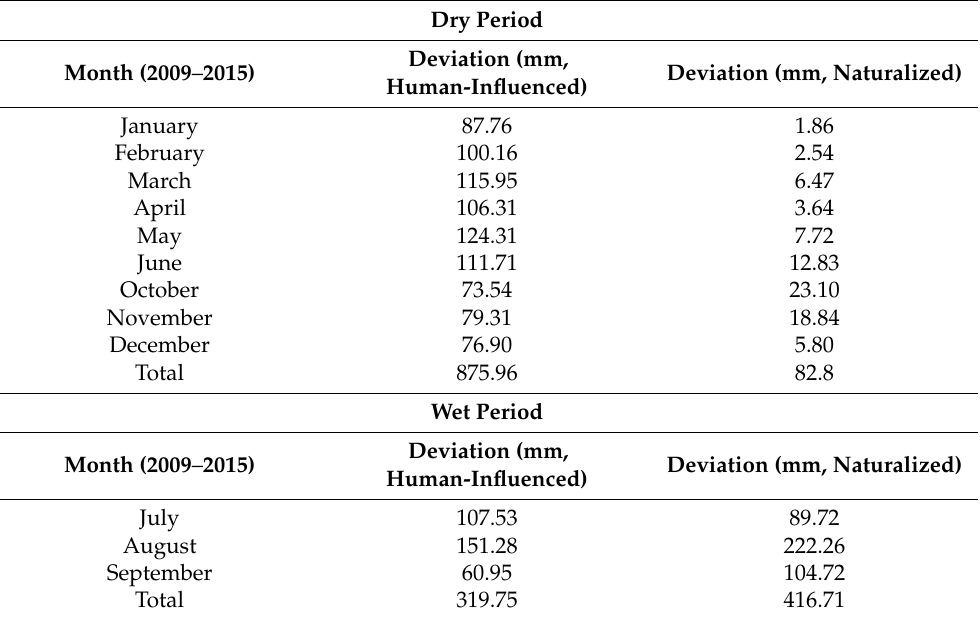
Table 4. Positive flow deviation from threshold (mm) for the dry and wet